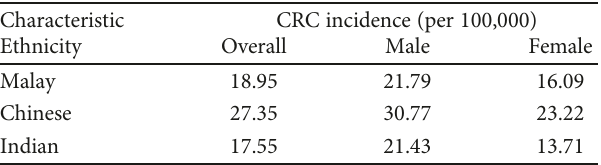
Table 2: Malaysia CRC incidence rate per 100,000 by sex and ethnicity from 2008 to 2013 (adapted and modi fi ed from Abu Hassan et al. [8]).